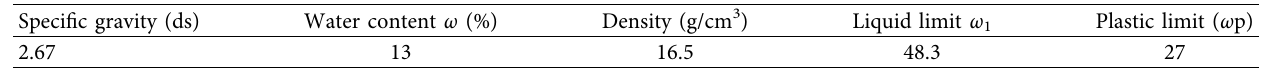
Table 1: Properties of granite residual soil samples.